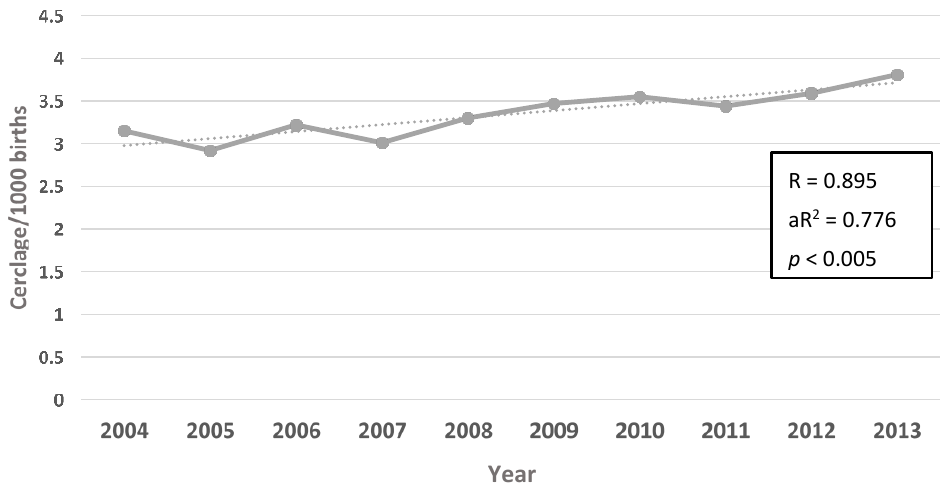
Figure 2. Overall incidence rate of cervical cerclage (procedures per 1000 births) in Australia for the period 2004 until 2013.